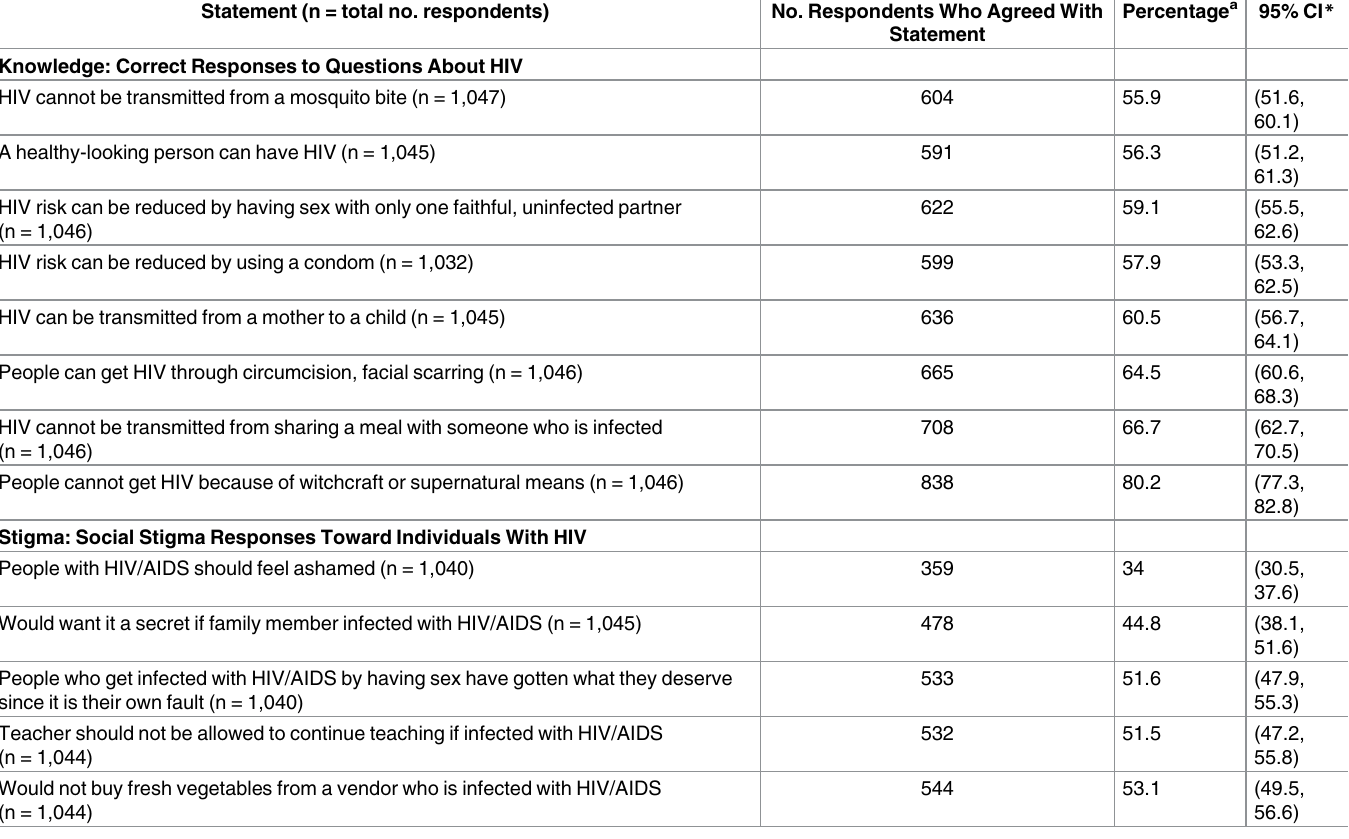
Table 3. Knowledge and stigma of HIV/AIDS among SPLA